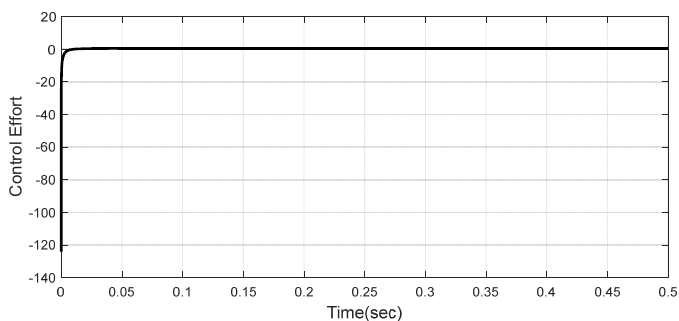
Figure 21. Controller effort signal in the presence of measurement noise.